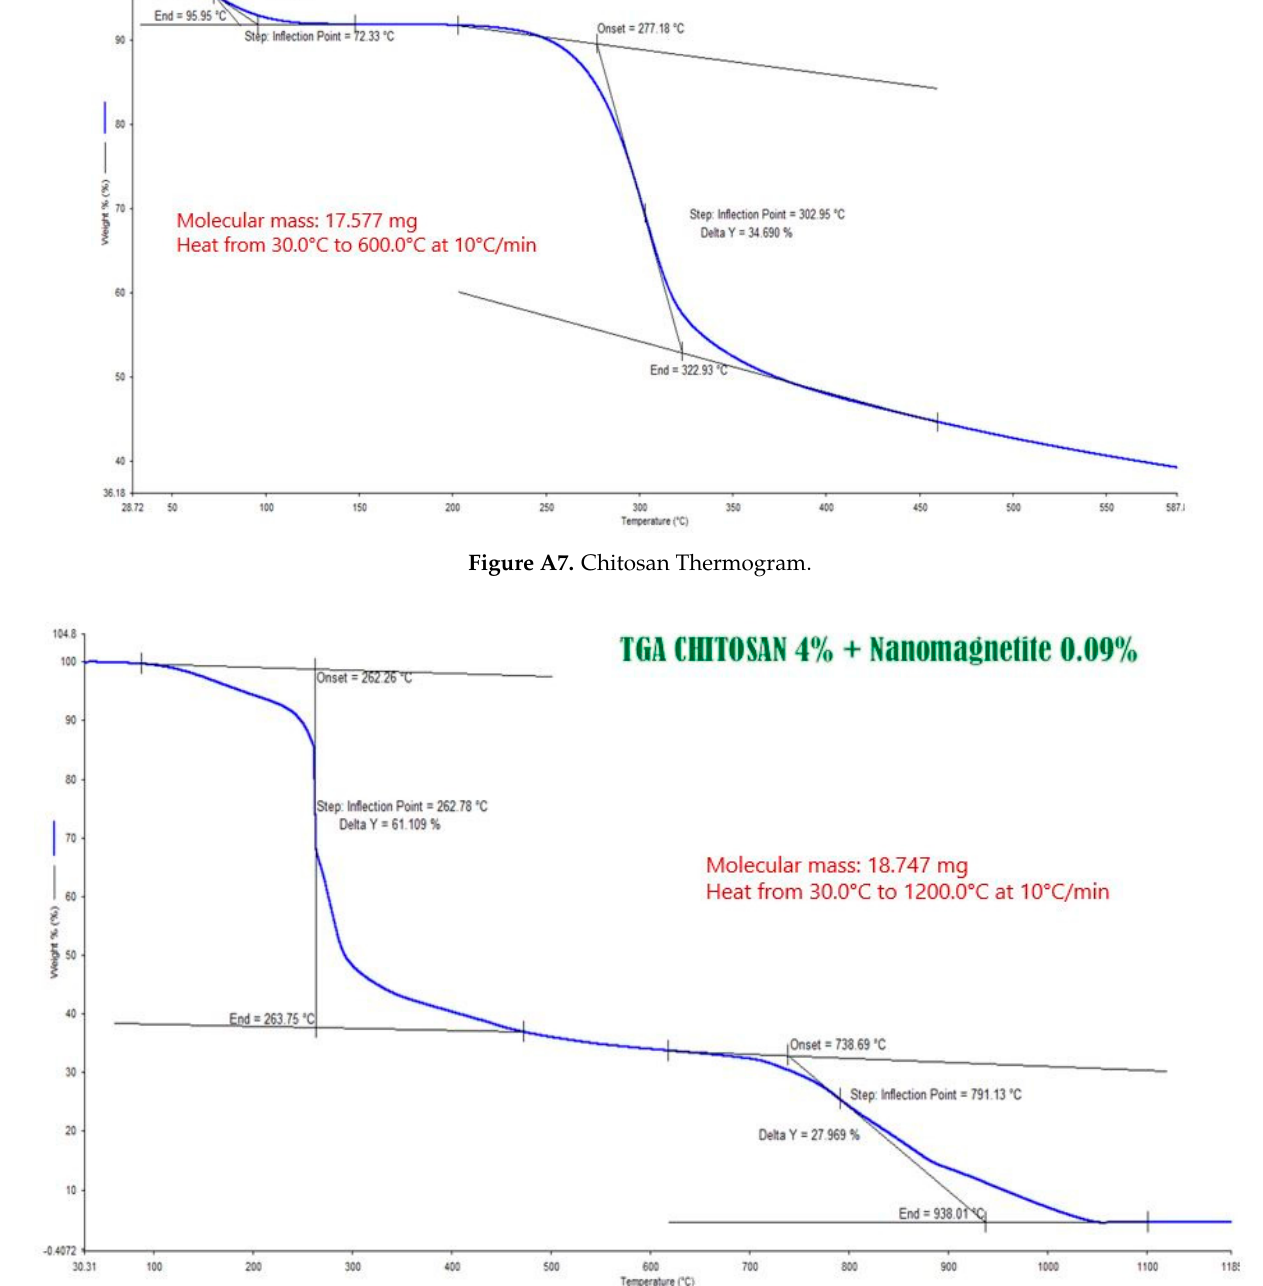
Figure A8. Chitosan 4% + Nanomagnetite 0.09% Thermogram.